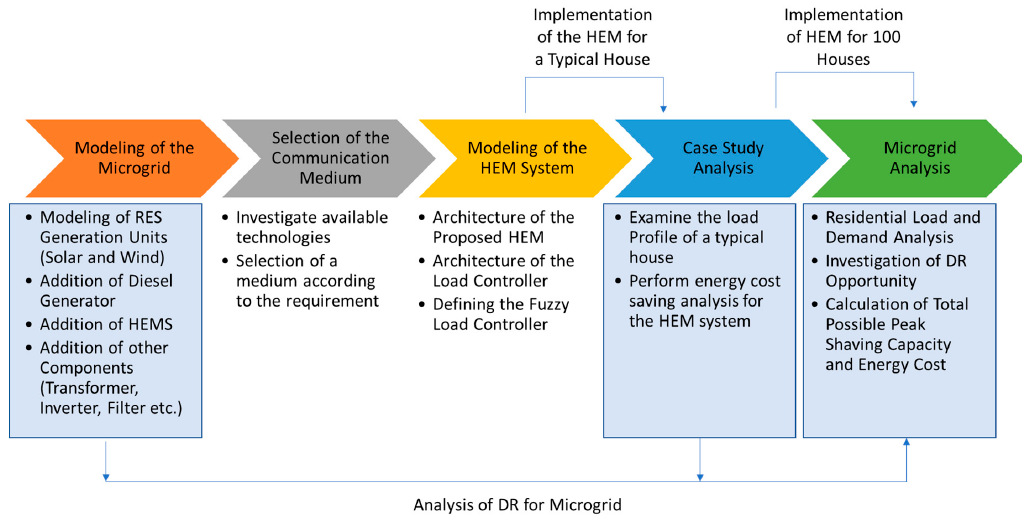
Figure 1. Methodology of the proposed study.